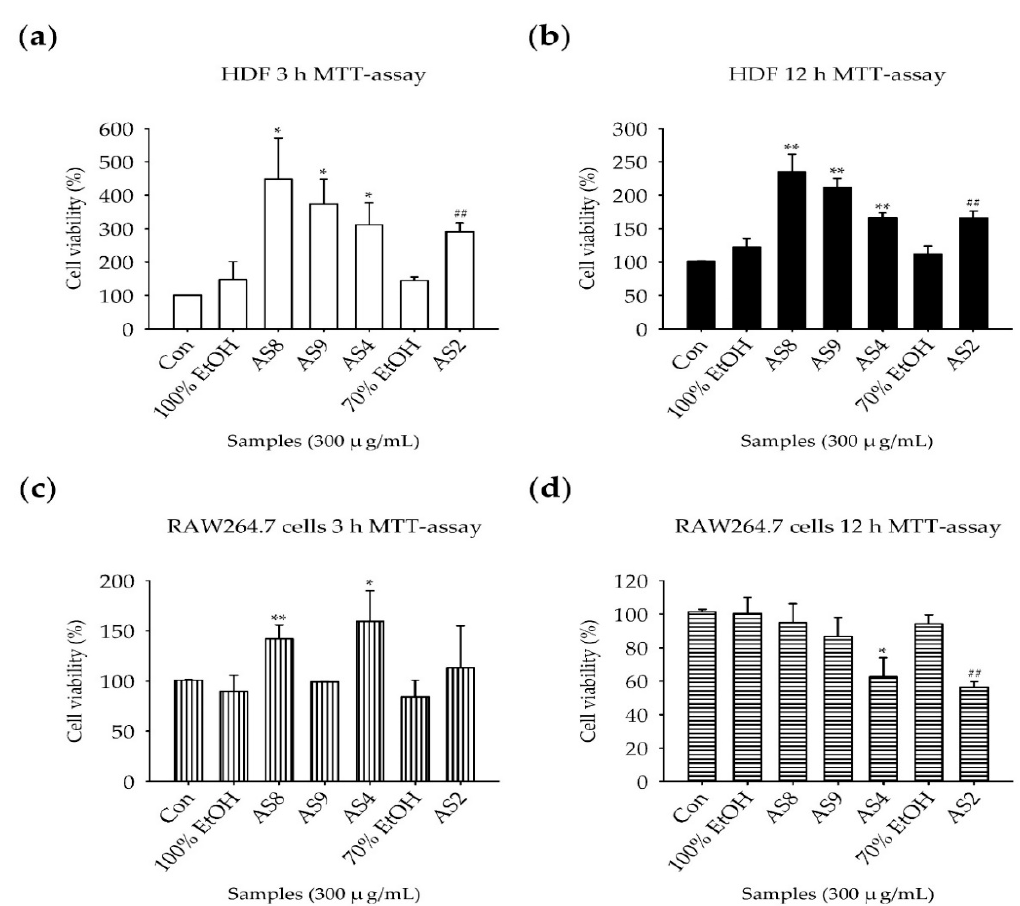
Figure 3. Cytotoxicity of AS extracts to human dermal fibroblasts (HDFs) and RAW264.7 cells: AS extract treatment for ( a ) 3 h in HDFs; ( b ) 12 h in HDFs; ( c ) 3 h in RAW264.7 cells; and ( d ) 12 h in RAW264.7 cells. Each extract was tested at 300 µ g / mL or 1000 µ g / mL for 3 h or 12 h before the